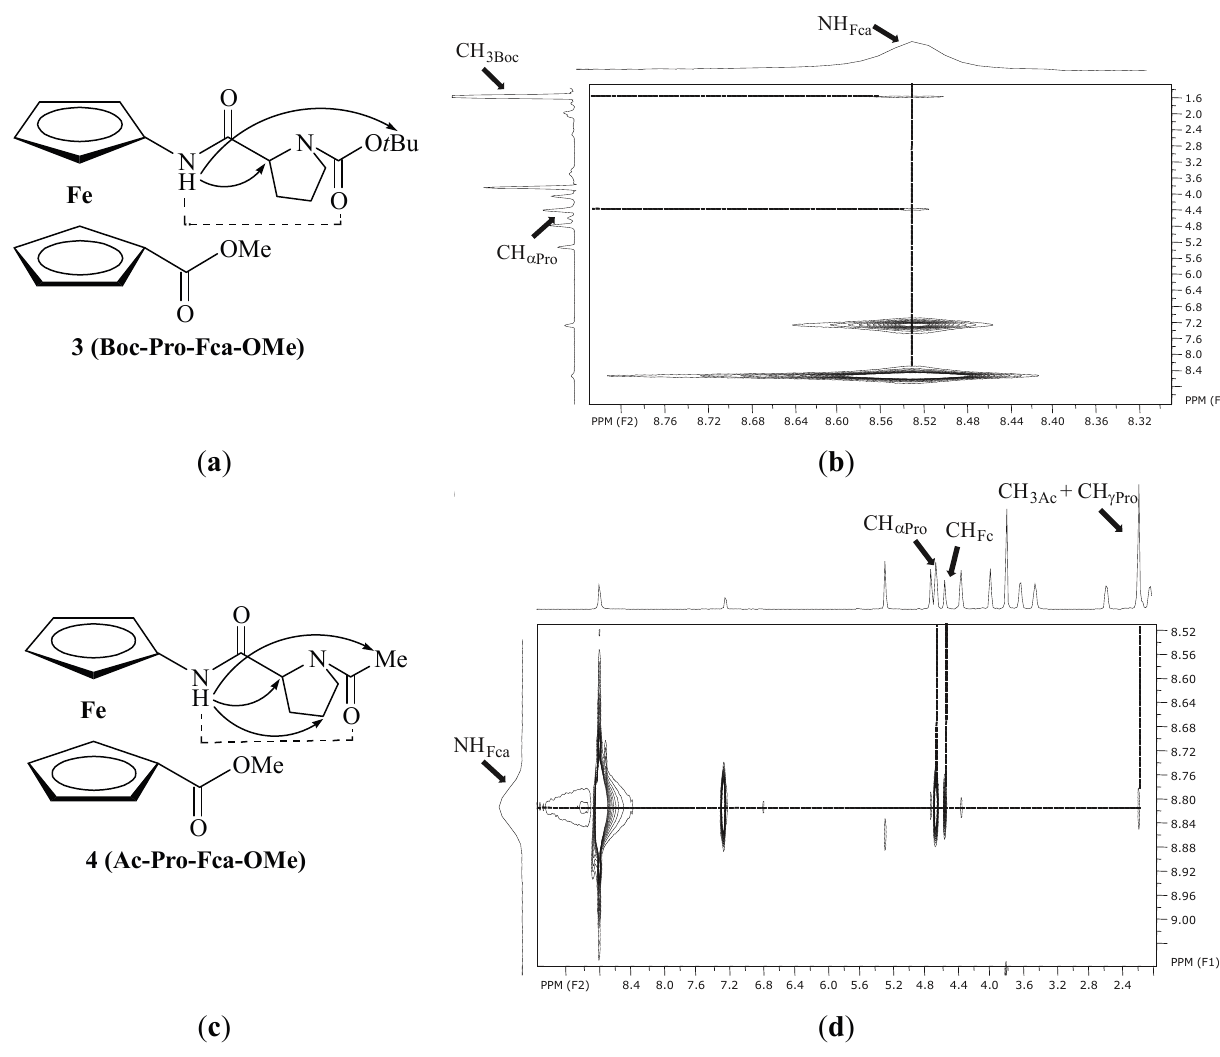
Figure 6. The proposed IHBs in peptides 3 ( a ) and 4 ( c ) are depicted with dashed lines and the intrachain NOE connectivities are presented with arrows; the intrachain NOE connectivities of 3 ( b ) and 4 ( d ) are depicted with dashed